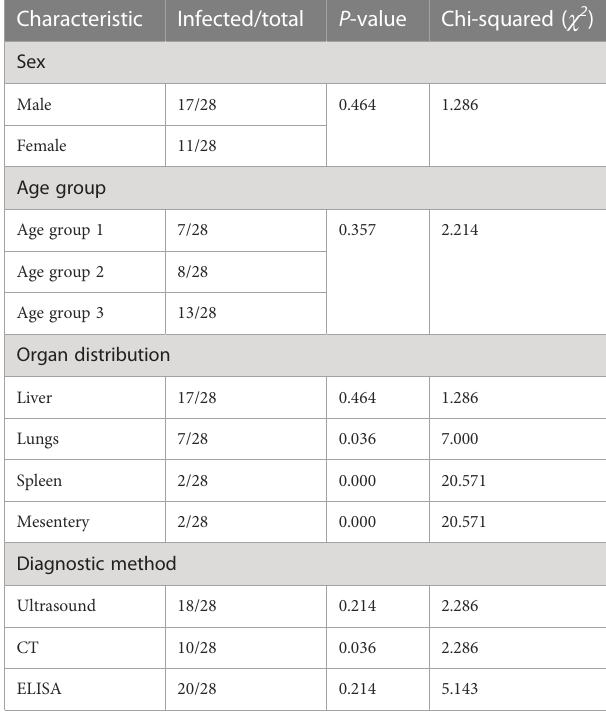
TABLE 1 Incidence rate of echinococcosis in the human population of southern